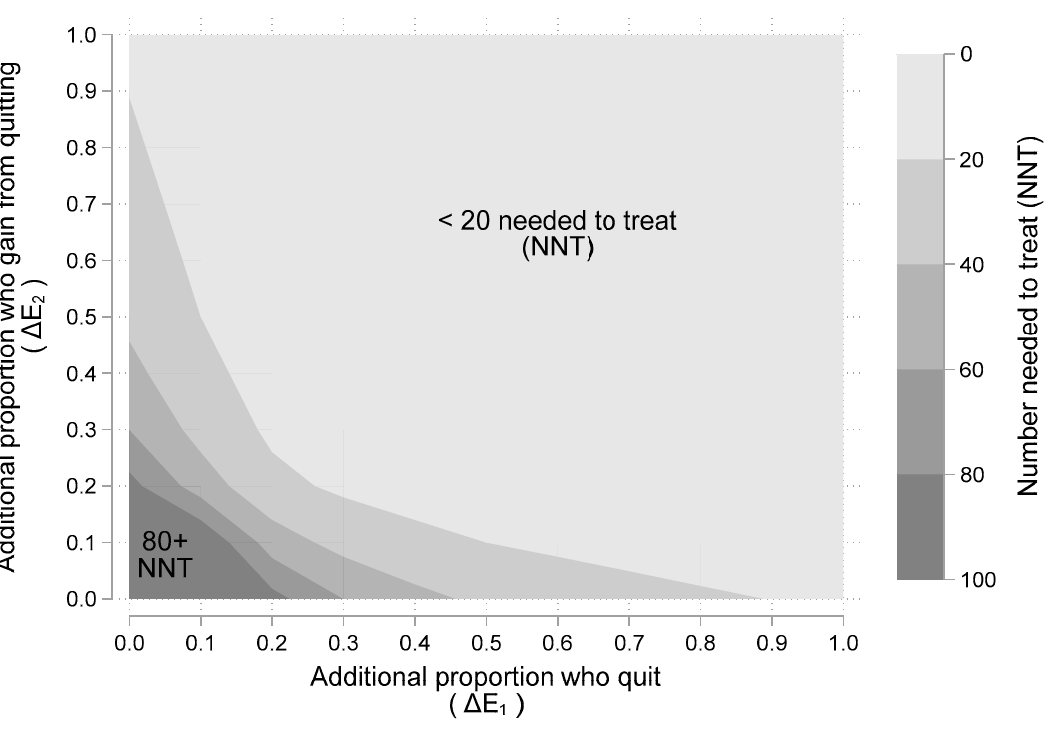
Figure 3. The “number needed to treat” (NNT) with a smoking cessation program for one more person to benefit. Note: Figure 3 illustrates a “two-way” sensitivity analysis illustrating the impact of different assumptions about the two main “chance” events: (1) additional proportion of people who quit (i.e., ∆ E 1 ); and (2) additional proportion who gain better outcomes from quitting (i.e., ∆ E 2 ). The shaded areas indicate number needed to treat (NNT) given assumed values for ∆ E1 and ∆ E 2 . Larger NNT values require more smokers being “treated” with a smoking cessation program (SCP) before one is helped.